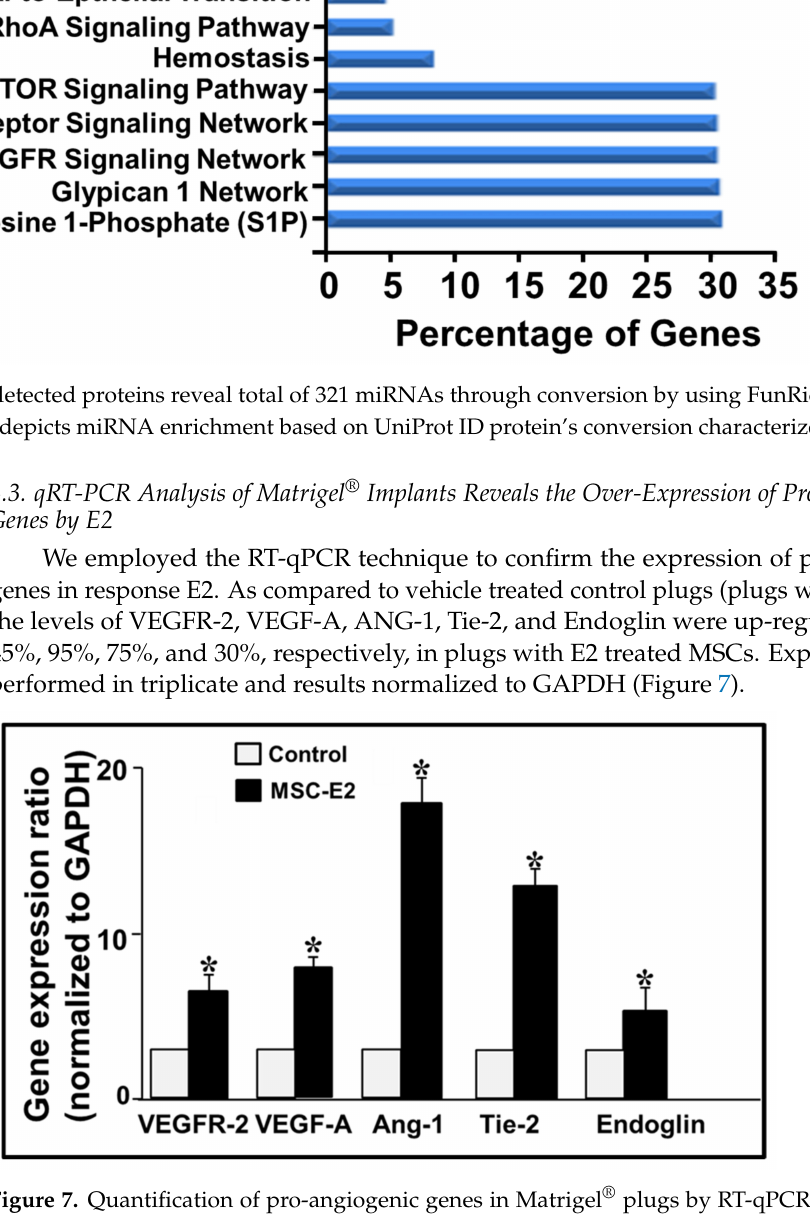
Figure 7. Quantification of pro-angiogenic genes in Matrigel ® plugs by RT-qPCR analysis shows enhanced levels of VEGFR-2, VEGF-A, Ang-1, Tie-2, and Endoglin modulated by E2 treatment of MSCs inserted in the Matrigel ® plugs. Experiments were performed in triplicate and the results normalized to GAPDH. * p < 0.05 versus Control (plugs with MSC only). Values represent the mean ± SEM from three separate experiments conducted in